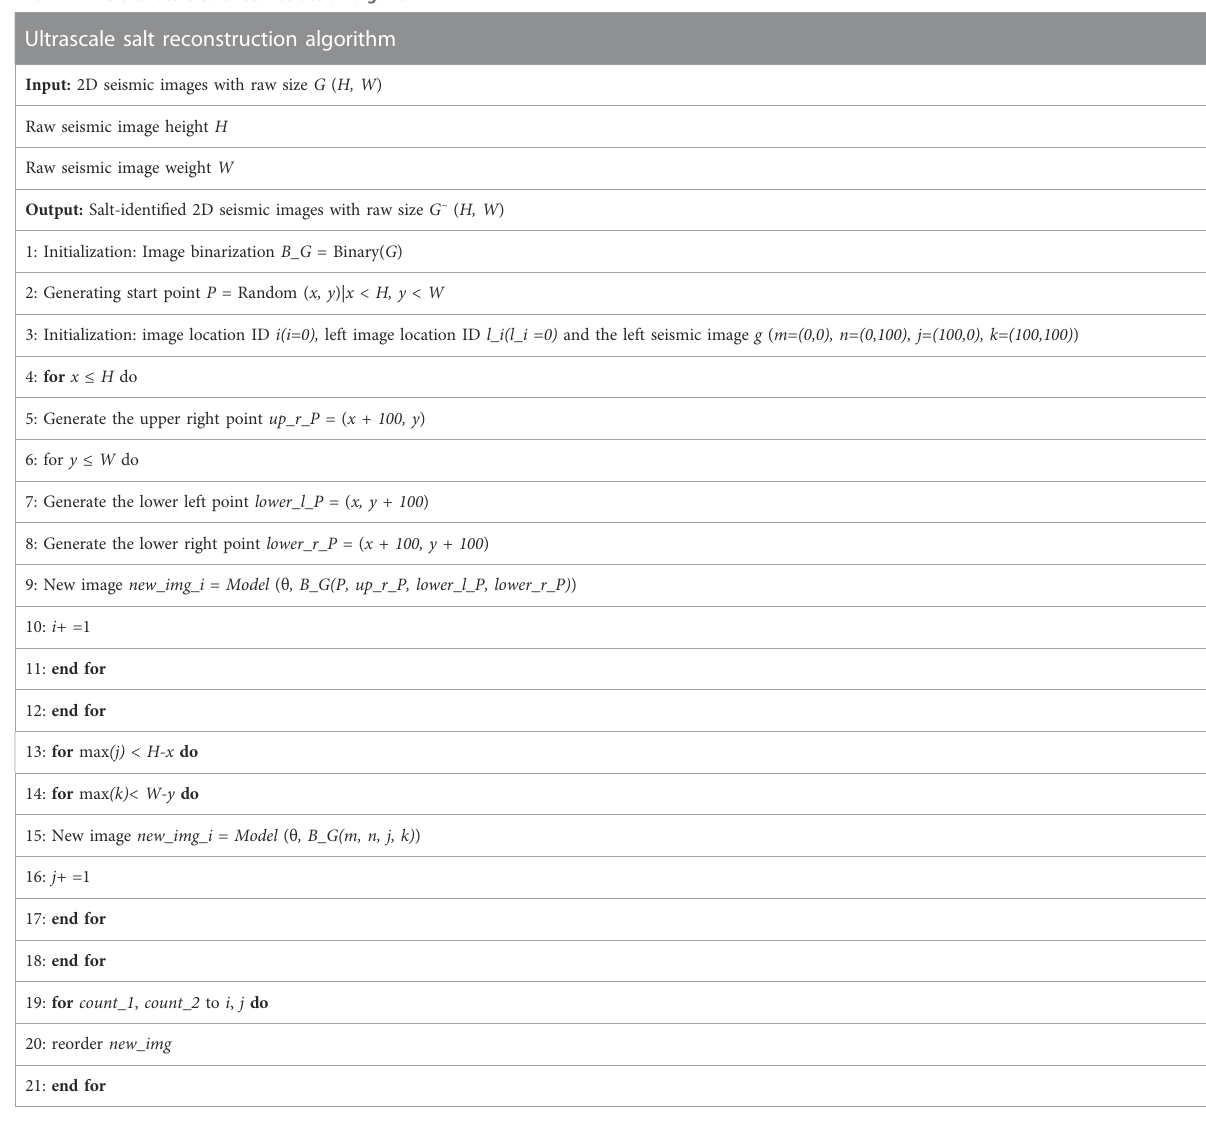
TABLE 1 The ultrascale salt reconstruction algorithm. Ultrascale salt reconstruction algorithm